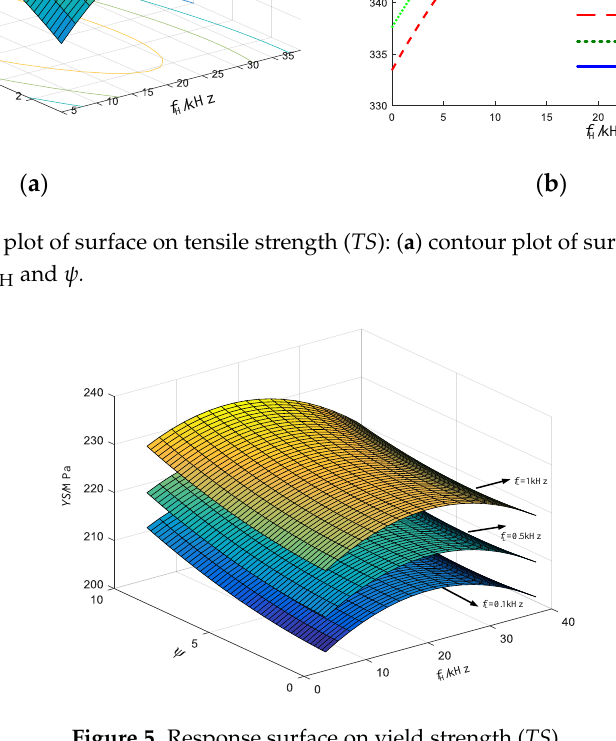
Figure 5. Response surface on yield strength ( TS ).